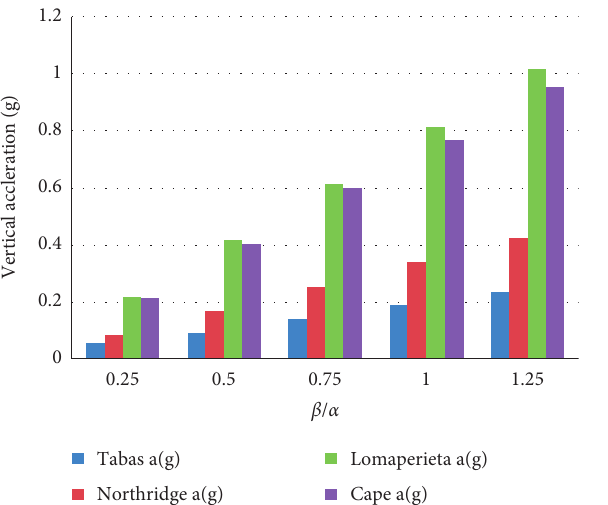
Figure 7: Maximum vertical acceleration of tunnel lining at loading 1 to 5.